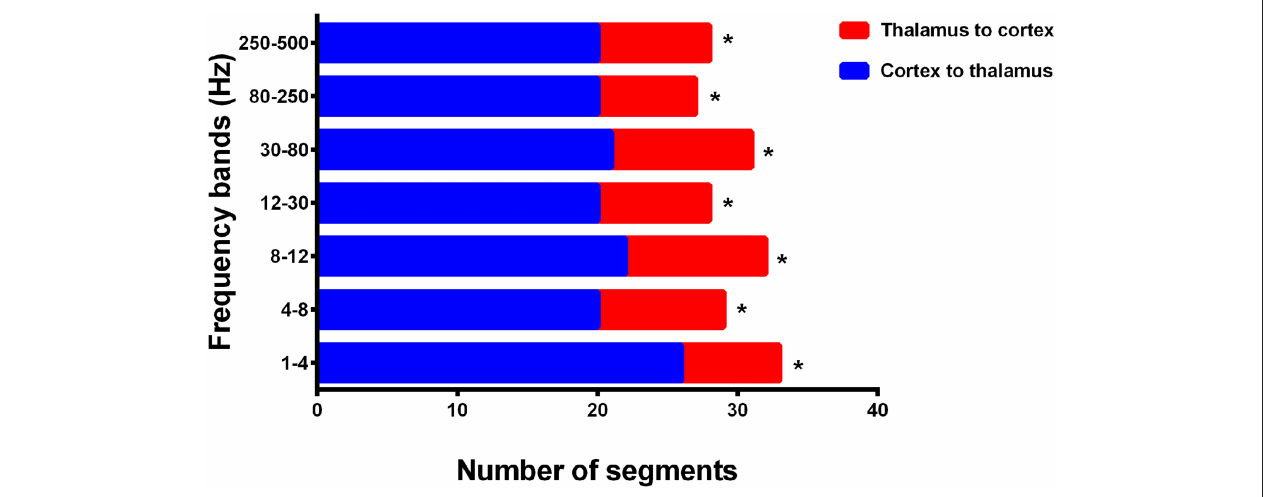
FIGURE 6 | Directionality of cortico–thalamic connection in all seven frequency bands. The numbers of segments (total 33 segments representing 33 seizures analyzed from 15 CAE patients) where cortico–thalamic connection is observed during corresponding periods are displayed on the x-axis, whereas the y-axis indicates seven frequency bands. Blue rectangles: the direction of cortico–thalamic connection is from cortex to thalamus. Red rectangles: the direction of cortico–thalamic connection is from thalamus to cortex. * p < 0.05 after FDR (corrected for 7